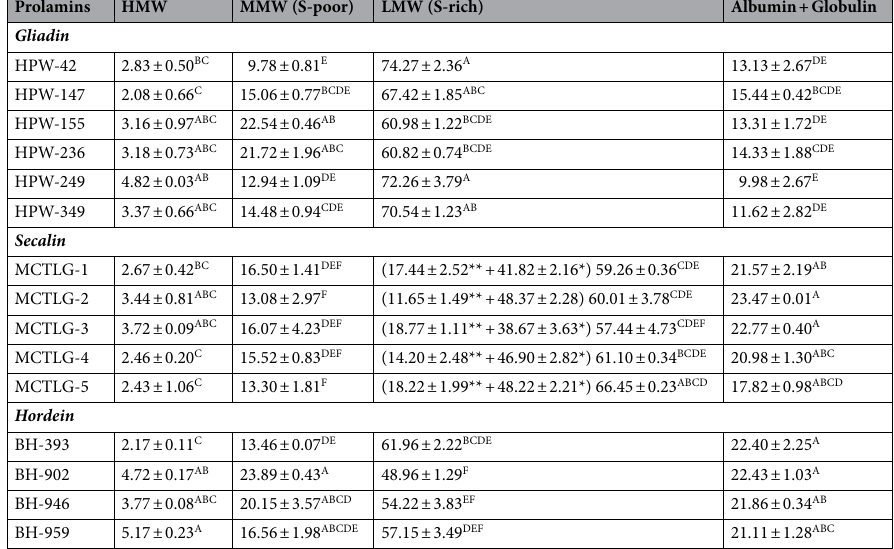
hordein to be 93.5%, 89.4% and 87.3% respectively using 5.7 conversion factor and alcohol extraction protocol. The difference in the crude protein content may be due to difference in extraction protocol, dialysis performed and also to some extent genetic makeup of cultivars. The color characteristics of the prolamin fractions were explained via CIE color values (L*, a*, b*, Hue angle (H o ) and Chroma (C*). L* value which indicates the lightness was found to be in the range 53.13–68.12 (Table S1). In the investigated cereals, the L* value for hordein fraction from BH-902 was found to be significantly (p ≤ 0.05) higher while lowest for secalin fraction from MCTLG-1. The dark color (lower L* value) of the secalins fraction might be due to the presence of pigment and oxidative changes as compared to hordeins and gliadins fraction 44 . In case of coordinates a* and b*, the observed positive values for prolamin fraction fall in the range 0.53–2.06 and 6.90–13.93 implying that prolamin fractions had red and yellow tinge respectively. For the investigated cultivars, the a* value was found to be the highest for gliadins fraction (1.53–2.06) and the lowest for hordeins fraction (0.53–1.28). On the other hand, the higher b* values for gliadins fraction (9.68–13.93) reflected more yellow tint in comparison to secalins fraction (6.90–10.13) and hordeins fraction (7.41–9.61). On the whole, a significant (p ≤ 0.05) difference in a* and b* values were observed among the prolamin fractions at inter as well as at intra-cultivars levels. Polypeptide characteristics. The gliadins, secalins and hordeins fraction were analysed for their elec- trophoretic pattern on SDS-PAGE (Fig. S1). The total number of polypeptides ranged from 16–21 in wheat cultivars, 14–16 in rye cultivars and 16–20 in barley cultivars. The prolamins polypeptides were sub-categorized as ω-gliadin, α/β–gliadin and γ-gliadin in wheat cultivars; C-hordein and γ/B-hordein in barley cultivars and γ-75 k-secalin, ω-secalin and γ-40 k-secalin in rye cultivars following Schalk et al. 13 . The High Molecular Weight (HMW) proteins in wheat, rye, and barley comprised of HMW- Non Gliadin components (HMW-NG), HMW- secalin, D-Hordein respectively. Medium Molecular Weight (MMW) proteins were ω-gliadin (wheat), ω-secalin (rye), and C-hordein (barley), while Low Molecular Weight (LMW) proteins were monomeric proteins (α/β– gliadin, γ-gliadin in wheat, γ-40 k-secalin in rye and γ-hordein in barley) and polymeric proteins (LMW-GS in wheat, γ-75 k-secalin in rye and B-hordein in barley). Minor traces of HMW-NG, HMW-secalin and D-hordein were observed in wheat, rye and barley cultivars respectively. These high molecular weight bands consisted of 2–4 polypeptides of M w 91.60–122.77 kDa in wheat cultivars and a single polypeptide of M w 93.37–106.37 kDa in rye and single polypeptide of M w 84.55–97.26 kDa in barley cultivars (Figure S1 a-c). Densitometric analysis (Table 1 and Figure S4) showed that the relative pro- portion of these HMW proteins varied from 2.08–4.82% in gliadins, 2.43–3.72% in secalins and 2.17–5.17% in hordeins. Schalk et al. 13 also reported SDS-PAGE of gliadin where HMW-NG accounted for 2.8%. The MMW proteins comprised of sulphur poor monomeric protein namely ω-gliadin which distinguished into 3–6 polypeptides of M w 52.91–88.82 kDa in gliadin, 2–3 polypeptides (M W 55.60–84.64 kDa) in C-hordein